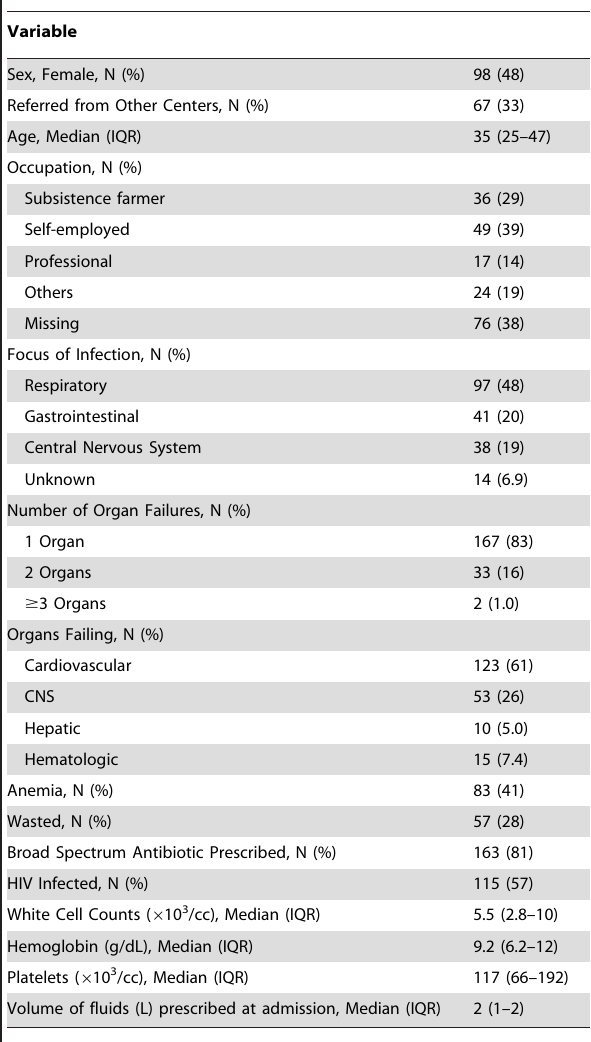
Table 1. Patient Characteristics at